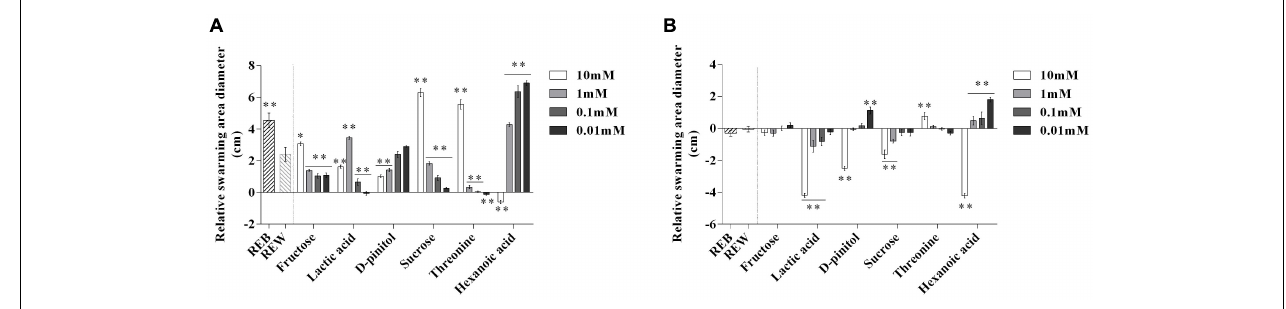
FIGURE 5 | Relative swarming motility of Bacillus cereus AR156 (A) and Ralstonia solanacearum HN4 (B) on 0.5% Luria-Bertan (LB) or 0.7% Yeast-Glucose-Peptone-Agar (YGPA) plates amended with tomato root exudate induced by Bacillus cereus AR156 (REB), tomato root exudate induced by water (REW) or different components from tomato root exudates induced by B. cereus AR156 at final concentrations of 0.01, 0.1, 1, and 10 mM centrally inoculated with 5 µ l of AR156/HN4 cells freshly grown (OD = 0.8) and incubated for 10 h and 5 days respectively at 28 ◦ C. The mean and standard error values of six biological replicates are reported for each treatment. Asterisks in (A,B) indicate statistical significance difference between data of treatments and data of tomato root exudate induced by sterile water (REW) within each experiment as determined by the Student’s t -test ( ∗ P < 0.05, ∗∗ P < 0.01). The experiment was carried out three times and one representative experiment is